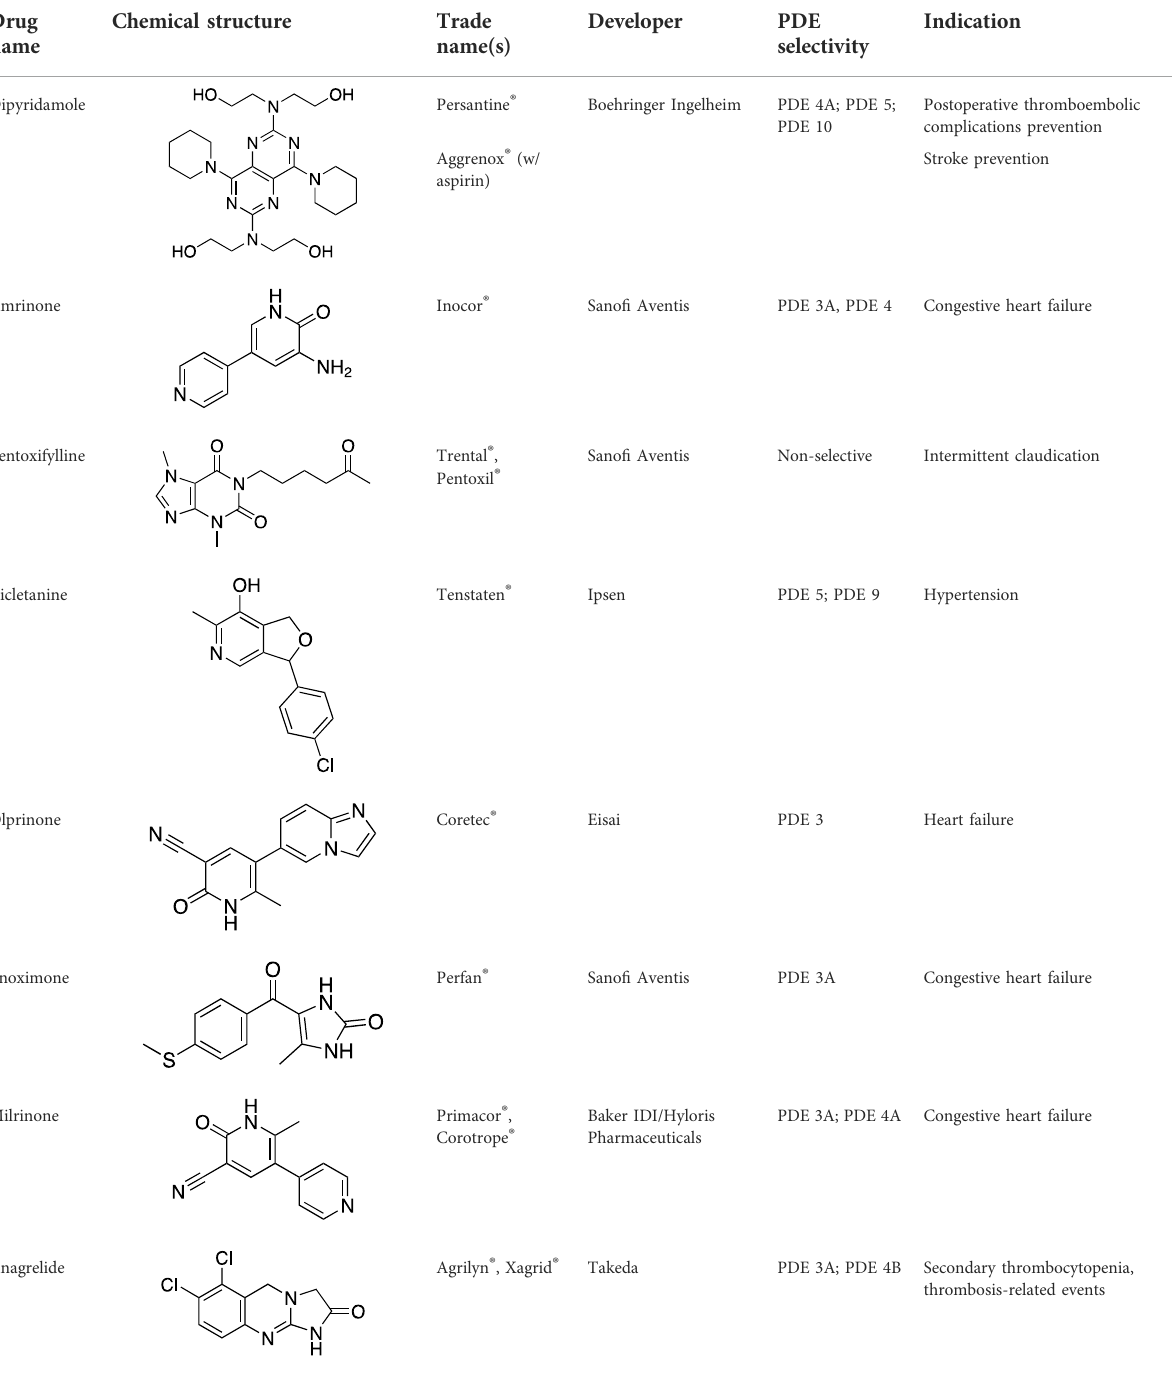
TABLE 3 Marketed PDE inhibitors in cardiovascular diseases. This table provides a summary on the available clinical evidence for marketed PDE inhibitors in cardiovascular diseases. Trade names, developer name and the targeted PDE isozymes are listed according to the PubChem